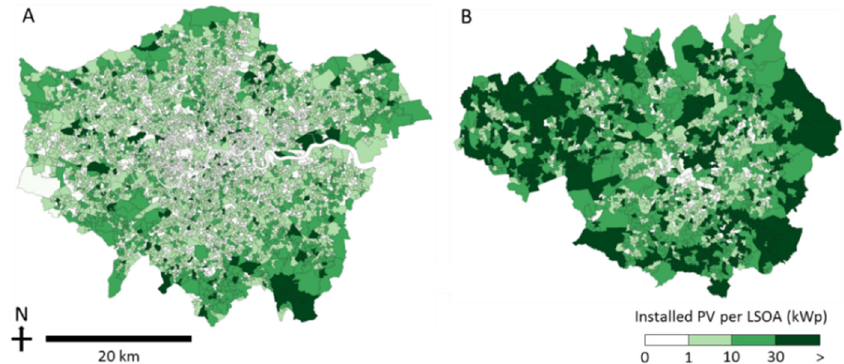
Figure 8. Domestic PV deployment in urban case studies, ( A ) Greater Manchester and ( B ) Greater London.